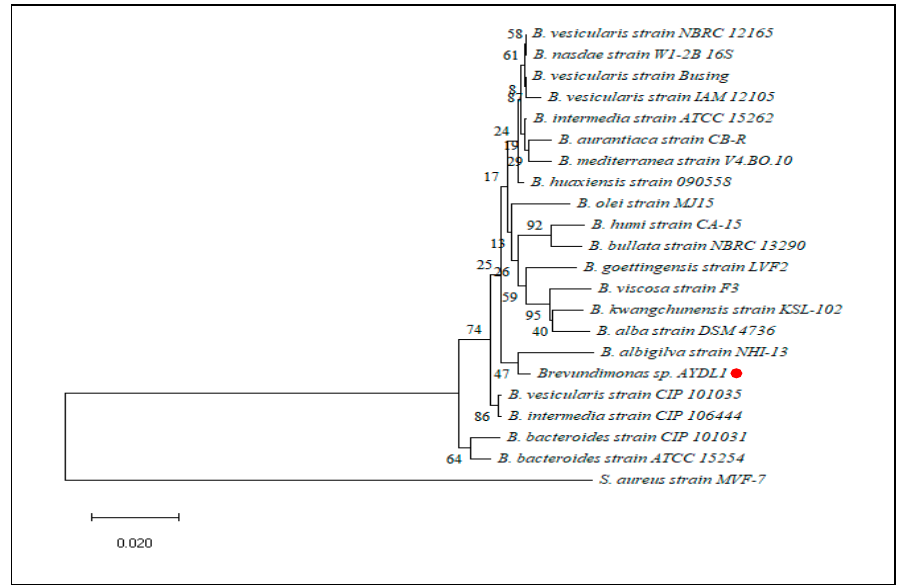
Figure 3. Phylogenetic tree of partial 16S rRNA gene sequences using the neighbour-joining method for AYDL2 ( ● ). (GenBank: OQ135212).